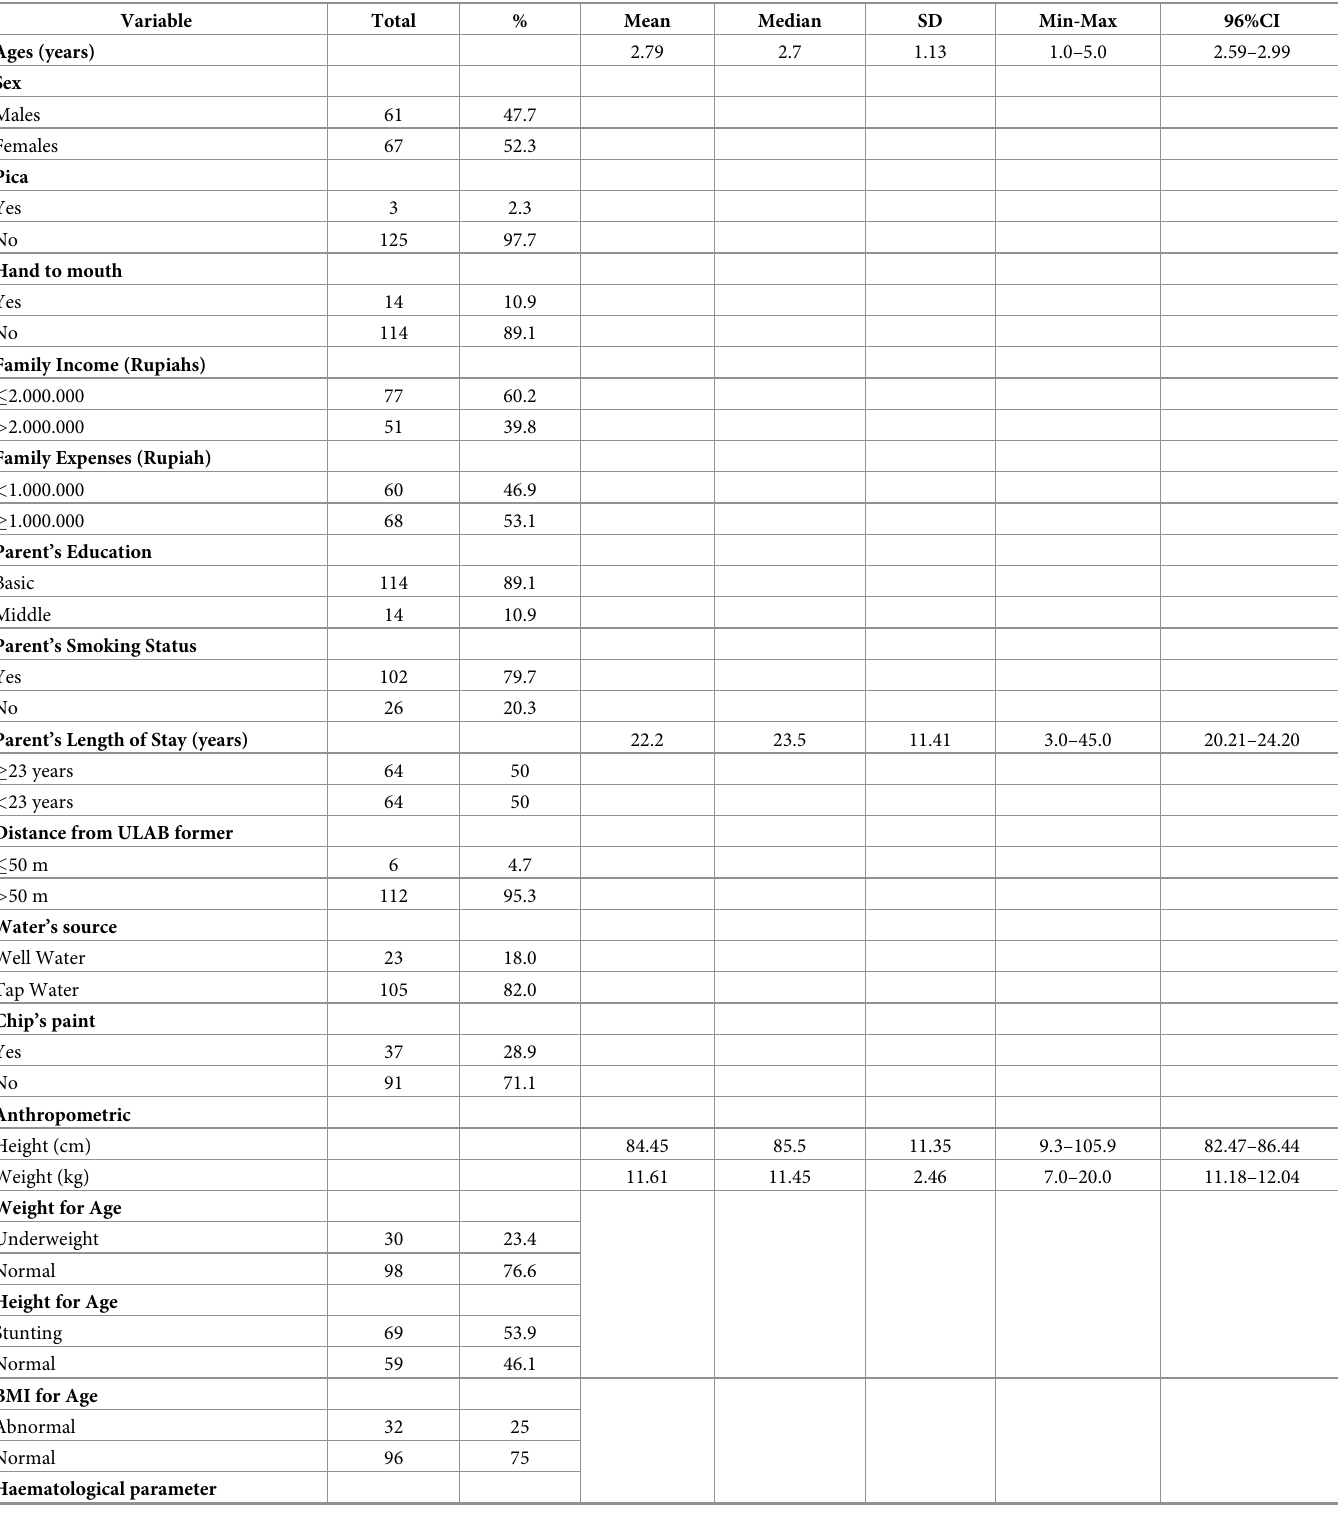
Table 1. Socio-economic characteristic of the study subjects (n =